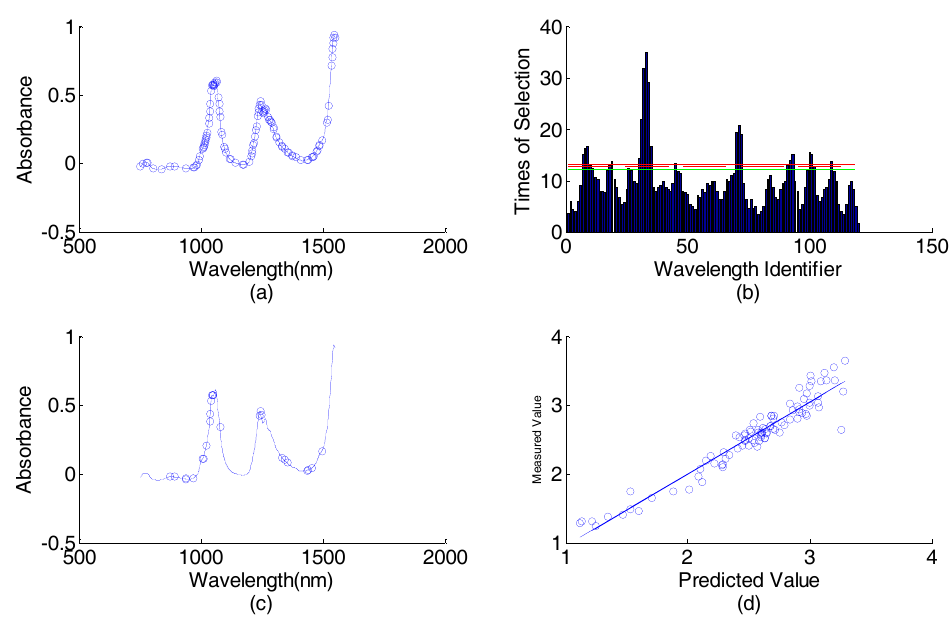
Figure 7. Diesel data (predicting viscosity content) wavelength selection result in the first round: ( a ) spectral responses vs. wavelengths, the 120 wavelengths selected by AP-PN are marked with circles; ( b ) times of selection (by GA-PLS) vs. wavelength identifier (1–120); ( c ) spectral response vs. wavelengths, the 25 wavelengths selected by AP-PN-GA-PLS are marked with circles; ( d ) scatter plot of predicted values vs. the measured values.